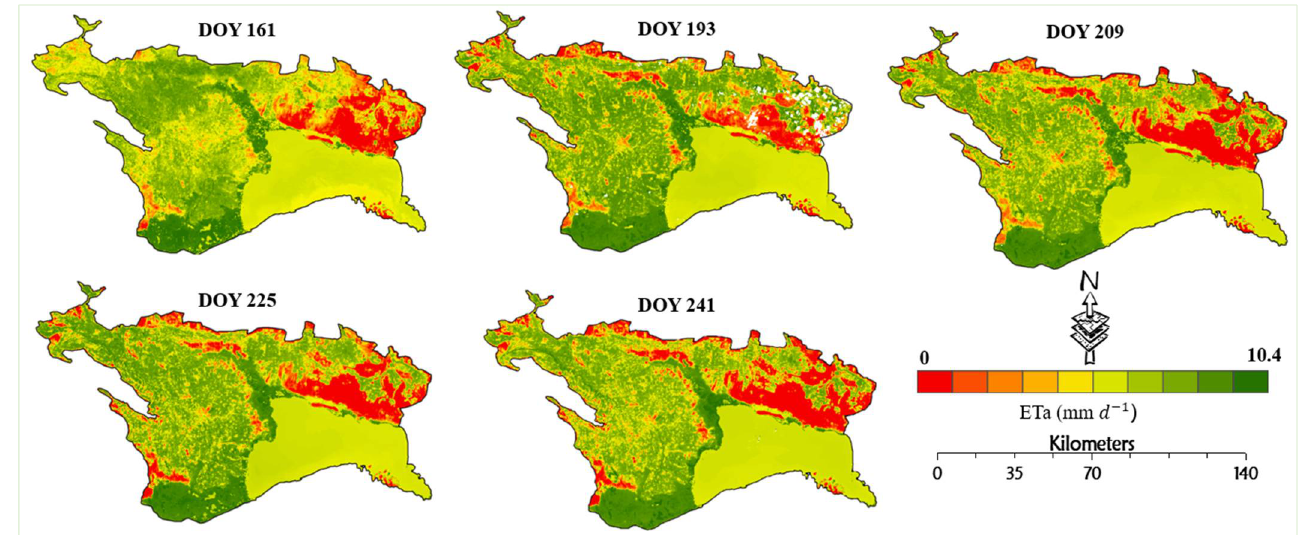
Figure 9. Spatial distribution of SEBAL derived daily ET (cid:2911) across Yanqi basin.